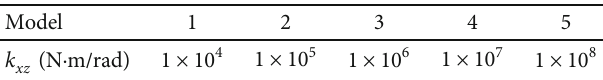
Table 9: Bending sti ff ness of